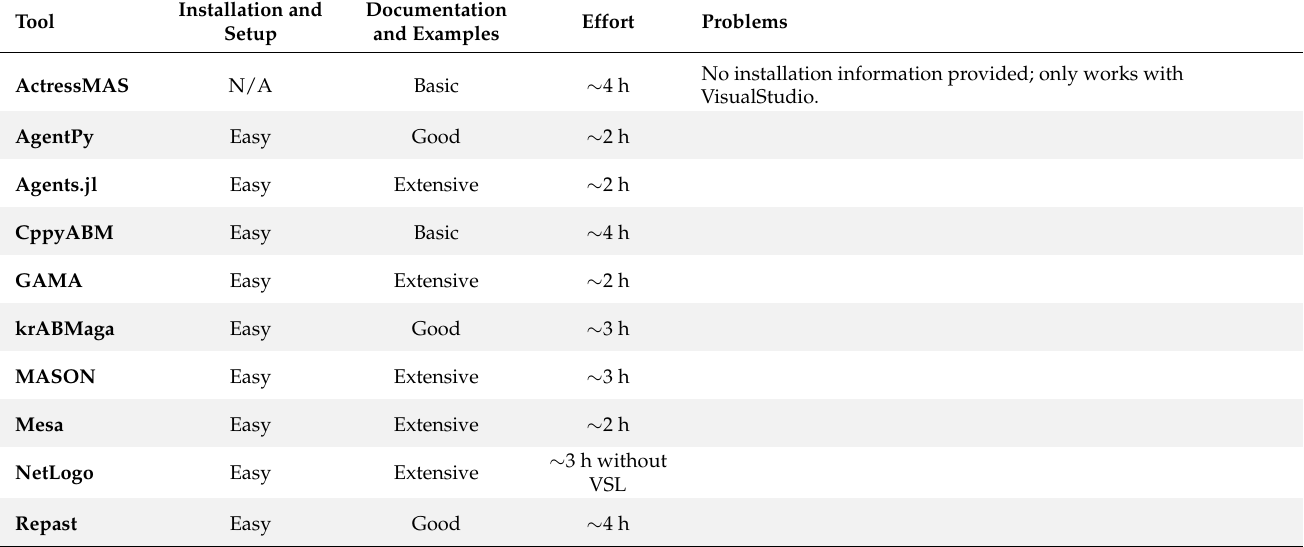
Table 6. Evaluation of ABM tools based on the perceived easiness in installing and using each tool. N/V stands for Not Verifiable due to the inability to install or use the corresponding